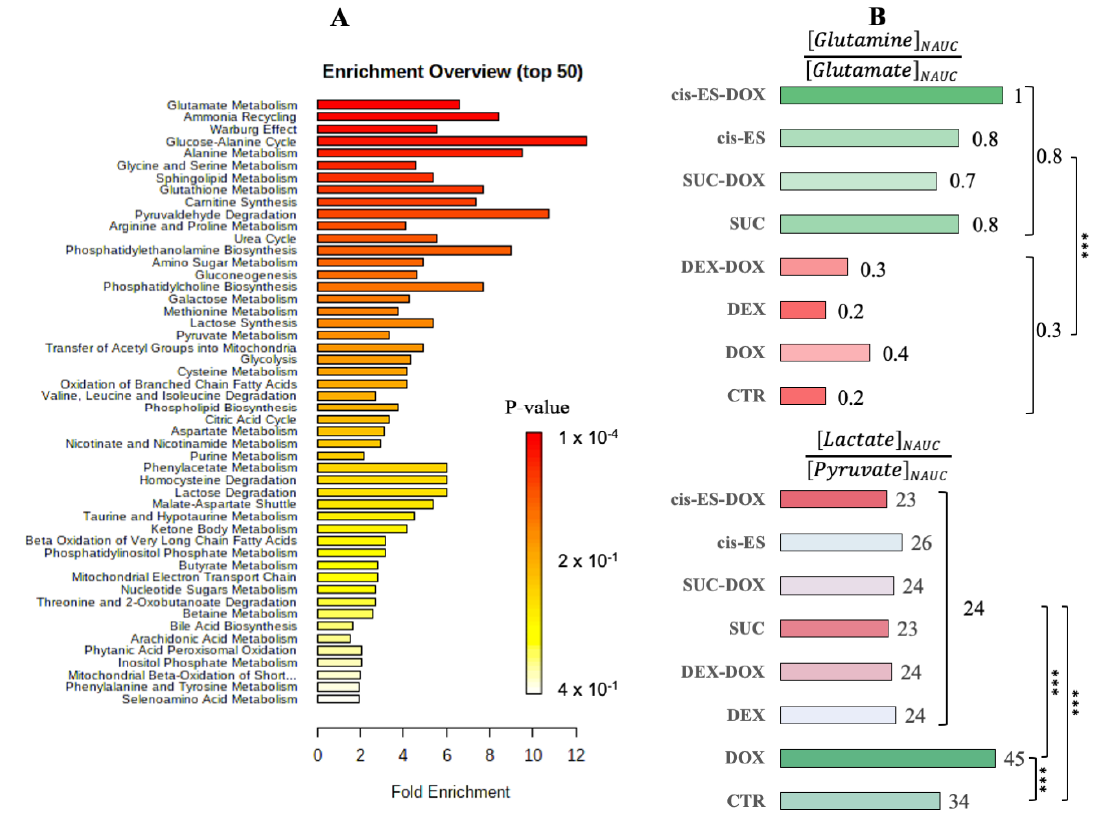
Figure 6. ( A ) Metabolite set enrichment analysis performed on the 1 H-NMR metabonomic data, using the MetaboAnalyst 4.0 online software. ( B ) 1 H-NMR intracellular glutamine-to-glutamate and extracellular lactate-to-pyruvate ratios calculated using the normalized integrals. Two-proportion z-test: *** p -value <